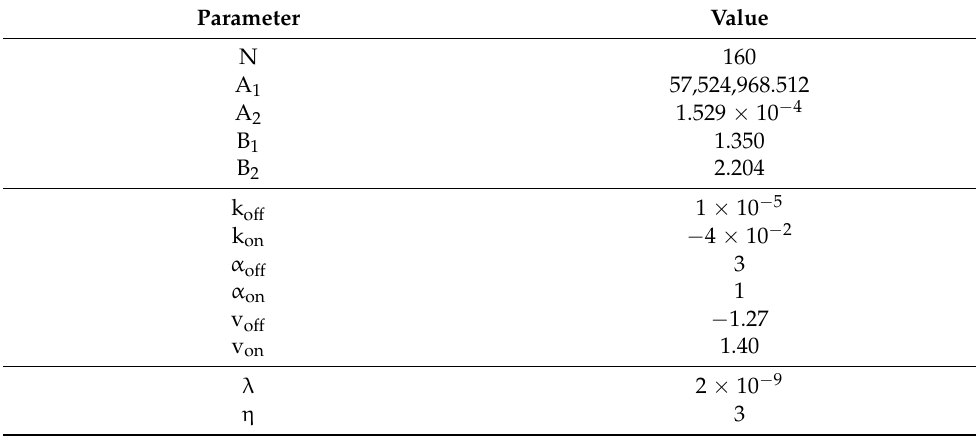
Table 1. Fitting parameters of unified RRAM device